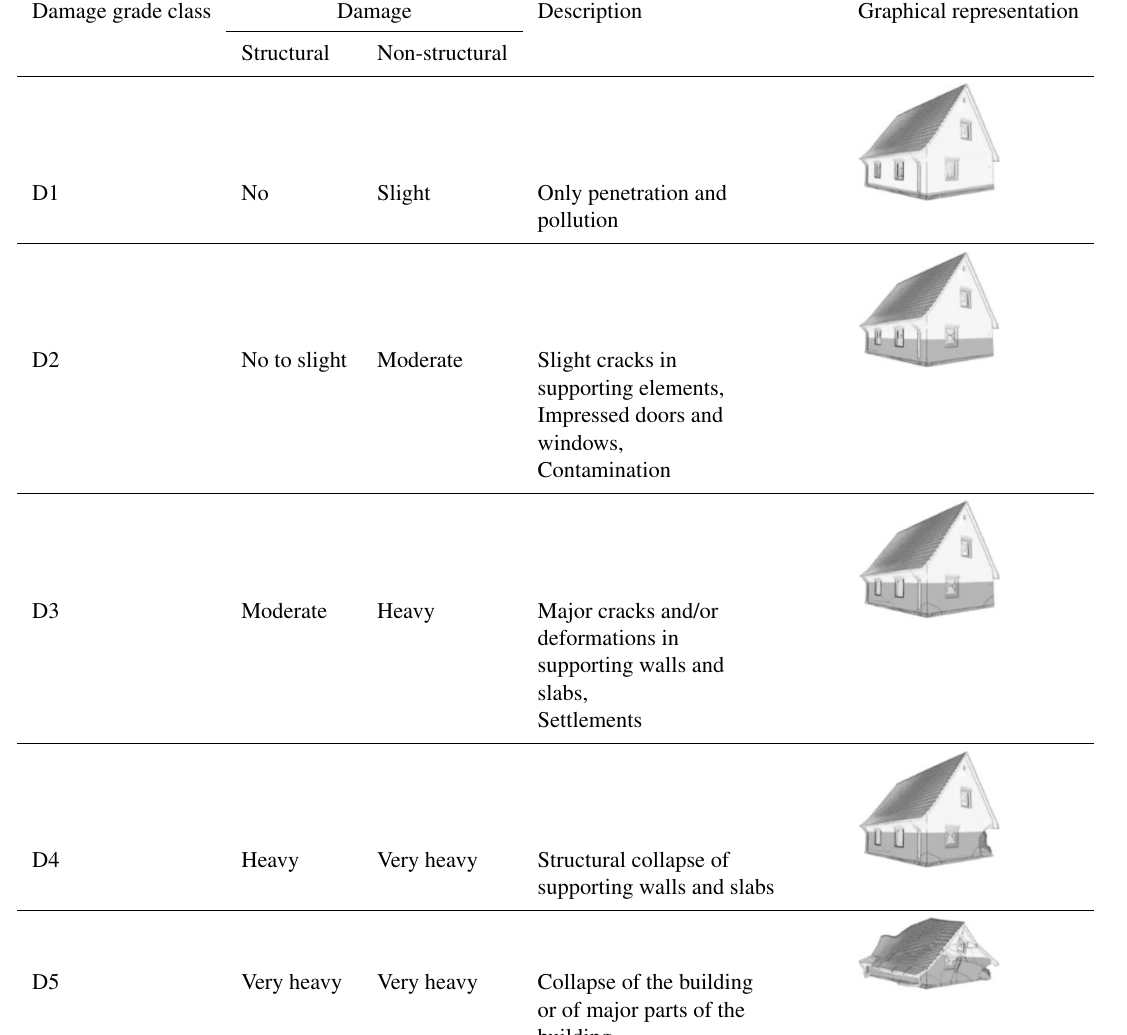
Table 3. Damage grades developed by Schwarz and Maiwald (2007) showing structural and non-structural damage to buildings. For each damage grade class, a description and a graphical representation are shown. The grey colour in the graphical representation indicates flood